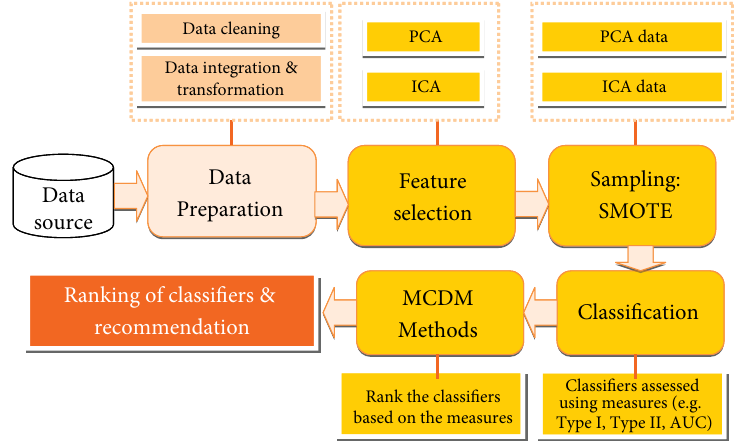
Fig. 1. Proposed approach for bank loan default